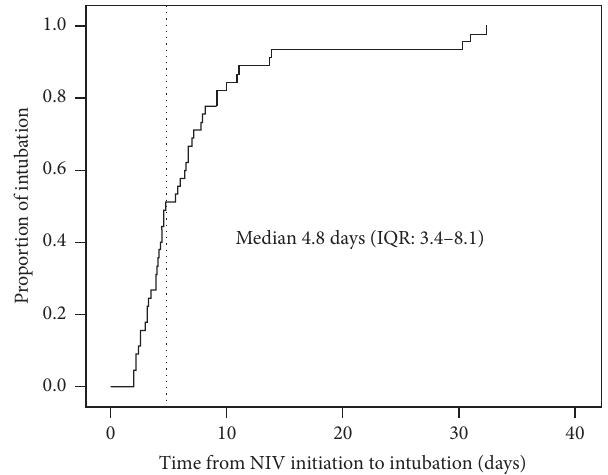
Figure 1: Proportion of intubation in patients with late failure of NIV. Table 1: Baseline characteristics of patients who had NIV success or late failure of